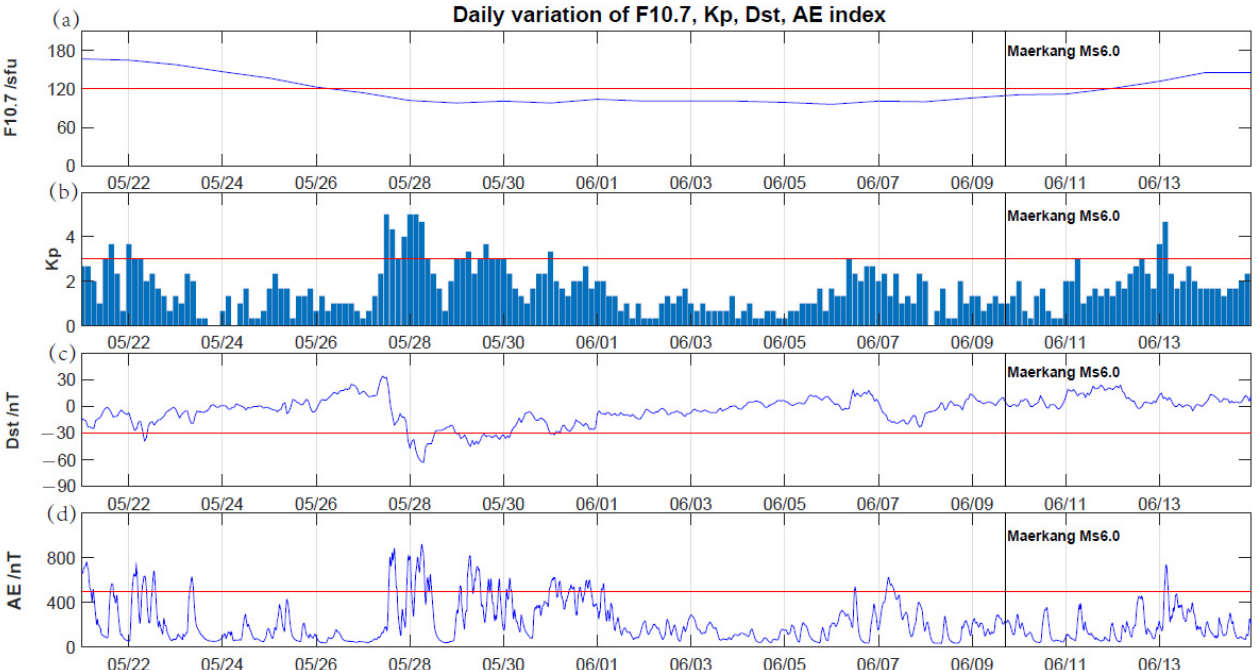
Figure 1. Daily variation of F10.7, Kp, Dst and AE indices, where ( a – d ) denote F10.7, Kp, Dst, and AE indices, respectively. In each figure, the black line indicates the time of the Maerkang Ms6.0 earthquake, and the red line indicates threshold value of each index.